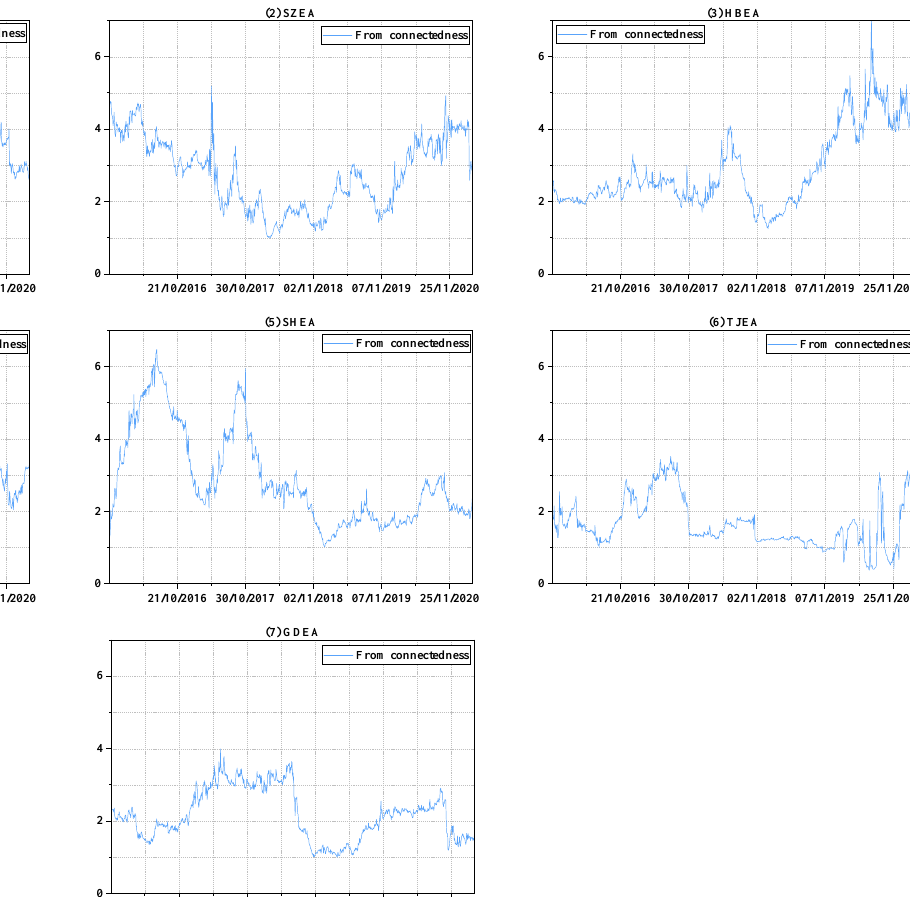
Figure 4. The dynamics of “from